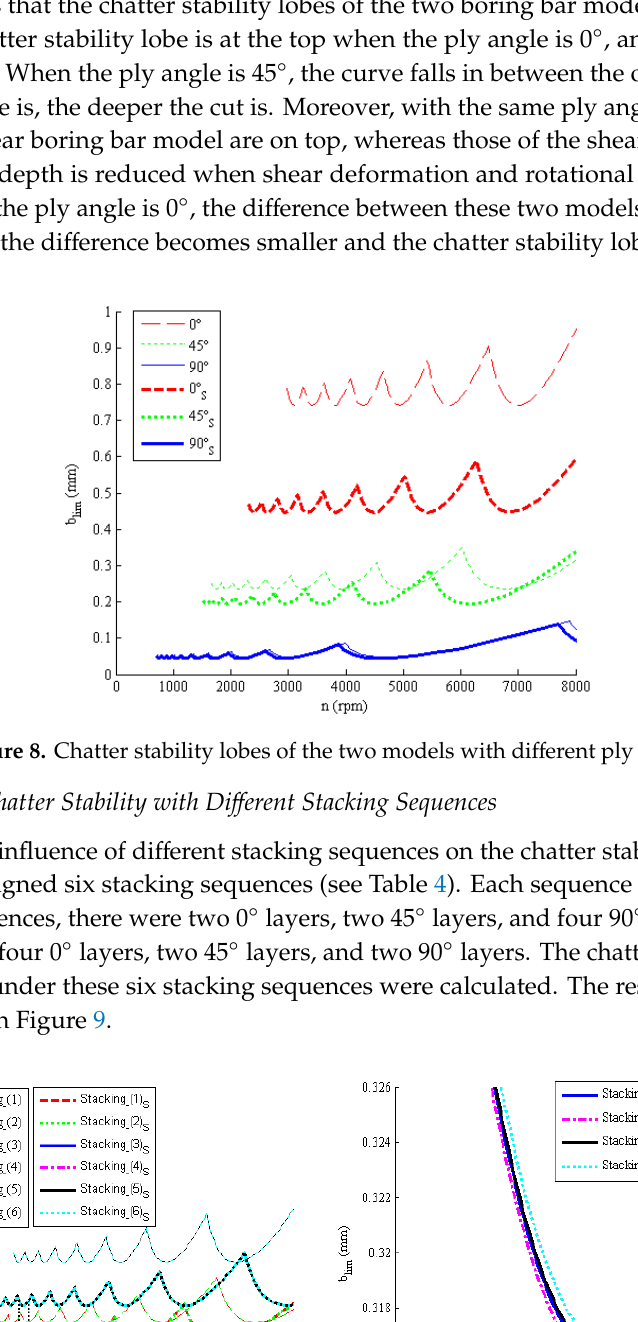
Figure 7. Chatter stability for different iteration numbers.